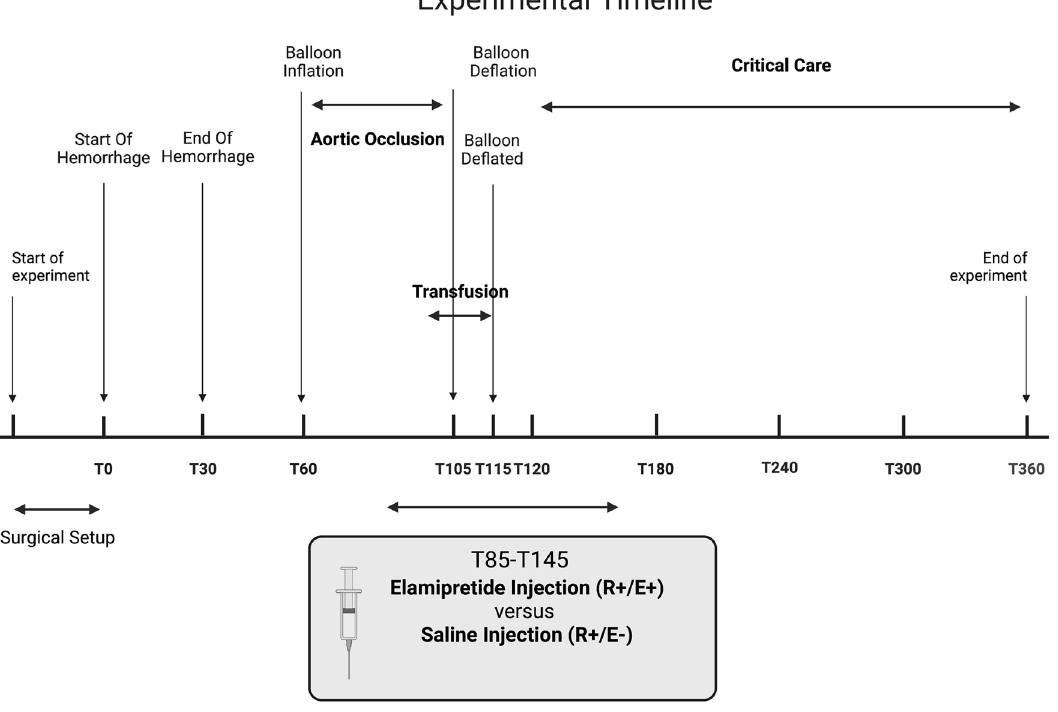
Figure 1. Experimental